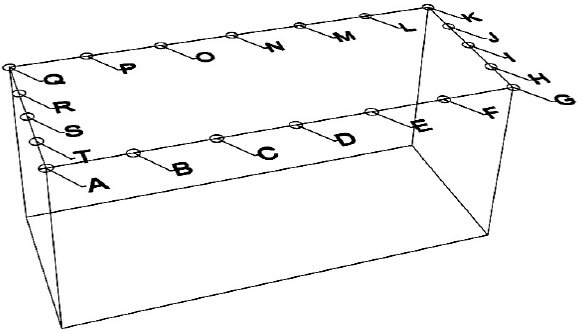
Figure 11. Pressure sensor locations in the numerical model.